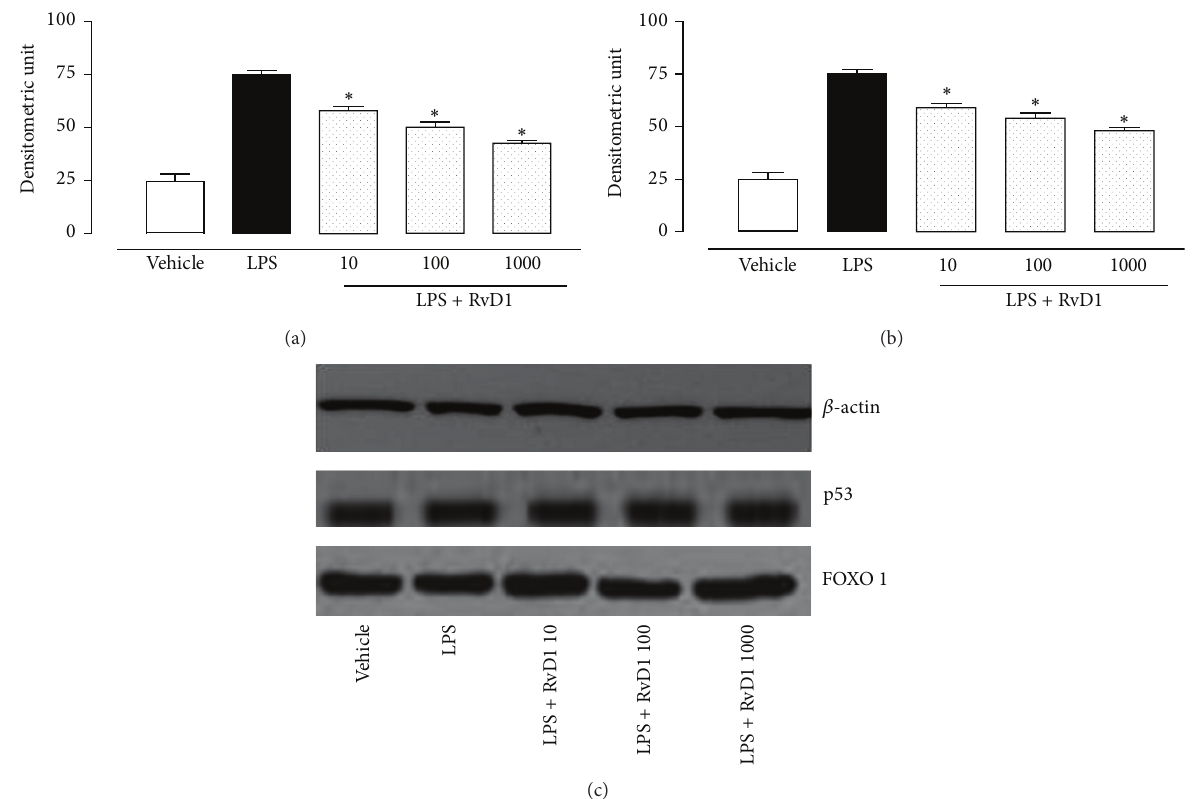
Figure 3: Intravitreal RvD1 (10, 100, 1000 ng/kg) in LPS rats reduced the expression of total p53 (a) and total FOXO1 (b). Values are reported as the mean ± S.E.M. of 𝑛 = 6 observations per group. ∗ 𝑃 < 0.01 versus LPS-treated group. RvD1 = resolvin